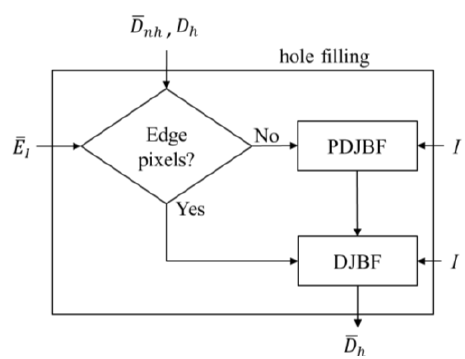
Figure 7. The flowchart of the hole region